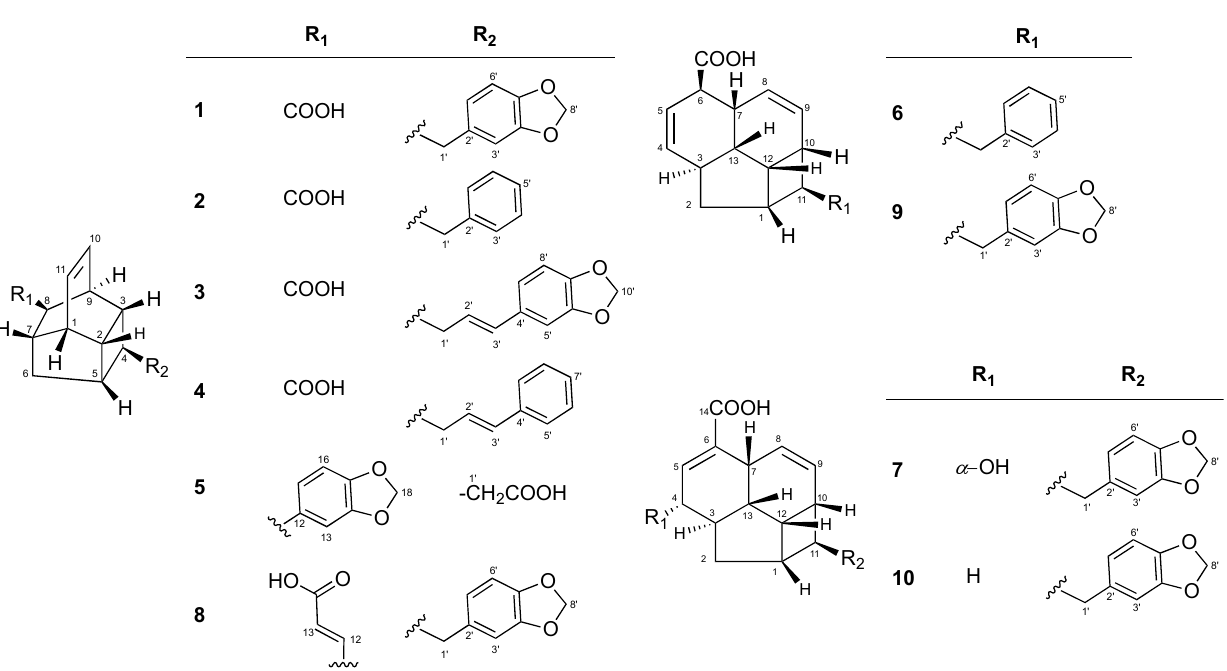
Figure 1. Structures of compounds 1 – 10